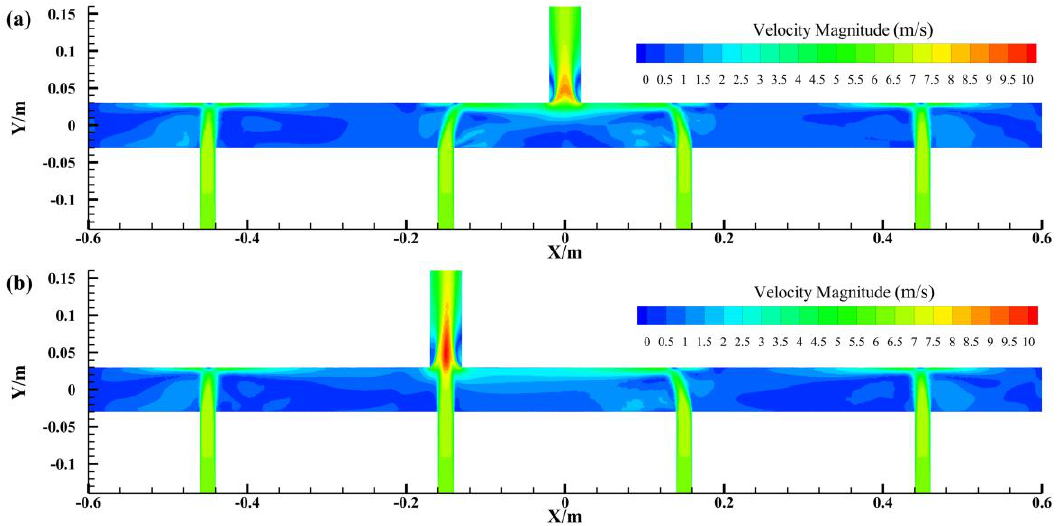
Figure 9. Velocity magnitude contours for Dc/d = 3 cases: ( a ) configuration “A”; ( b ) configuration “C”.